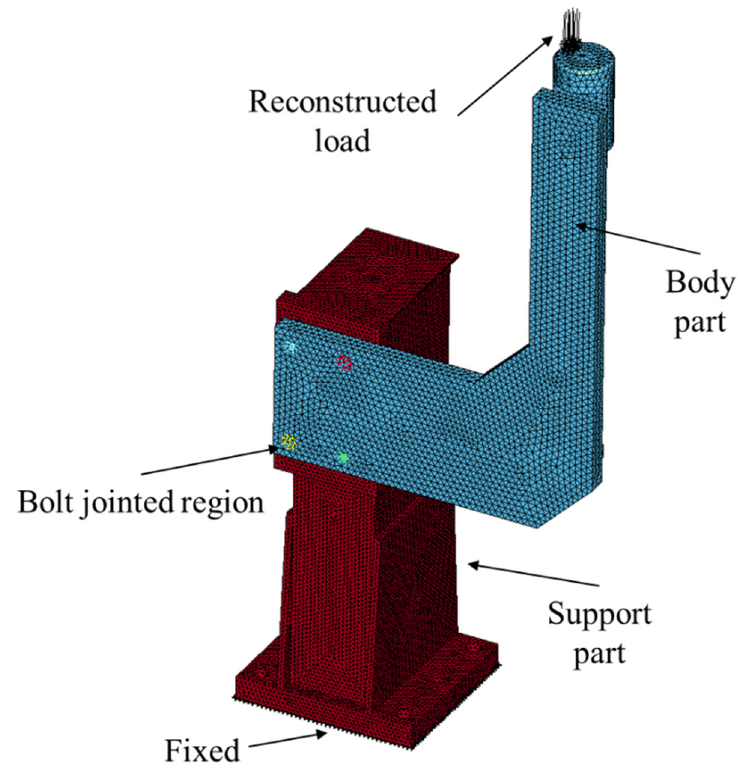
Figure 9. Finite element model of production equipment.